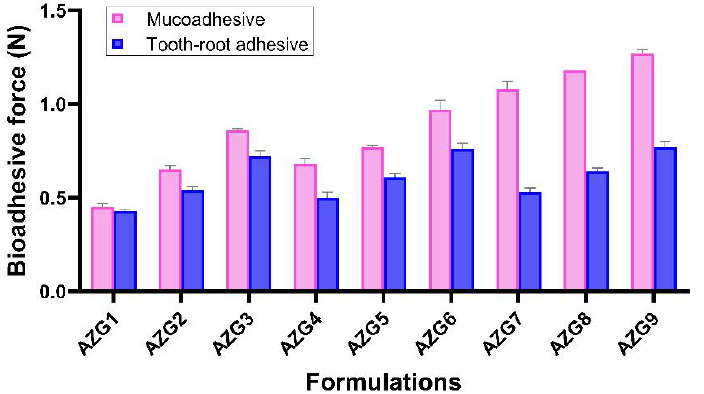
Figure 3. Bioadhesive force of AZG formulations representing adhesion to mucosa and tooth-root surface (mean ± SD, n = 3).